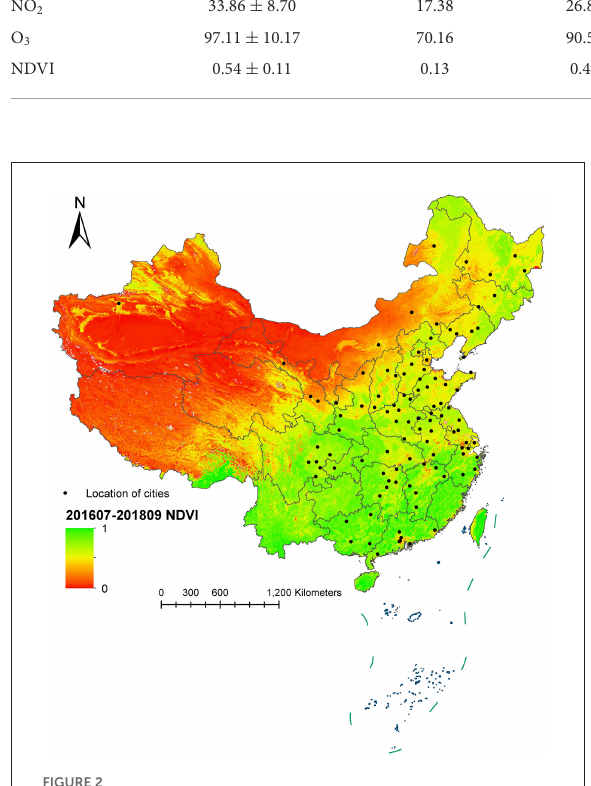
FIGURE2 Average concentration distribution of the NDVI during July 2016 to September 2018 in